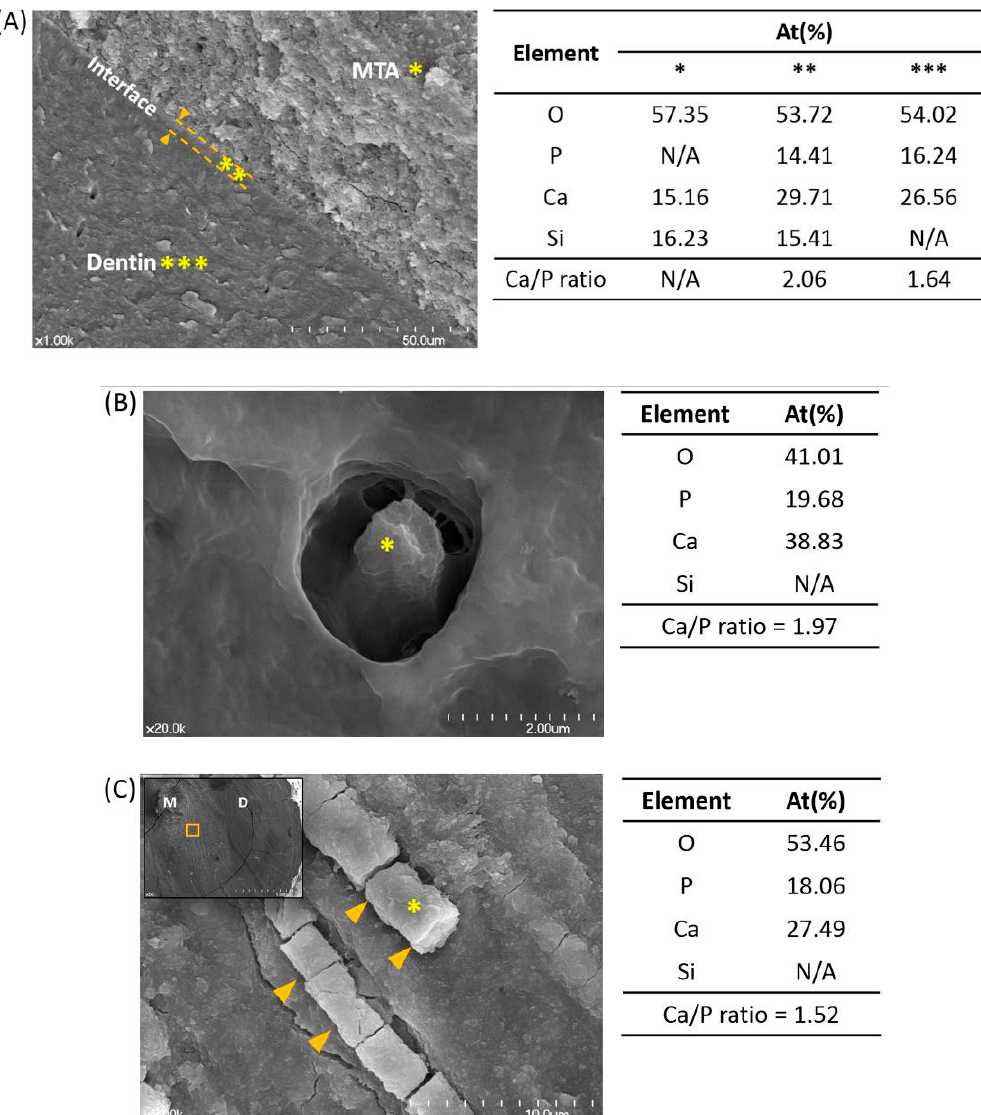
Figure 2. Scanning electron microscopic images that are representative of the root canal dentin and mineral trioxide aggregate (MTA) interface. ( A ) There was an intermediate layer (**) at the interface of MTA (*) and dentin (***) (×1000). ( B ) A dentinal tubule that was occluded by a mineralized structure (×20,000). ( C ) Higher magnification image (×50,000) of yellow boxed area in upper left image showing horizontal cross-sectional view of the root (×50). Biomineralized dentinal tubules (arrowheads) at 1.0–2.0 mm distance from root canal. M: mineral trioxide aggregate; D: dentin. Tables show semiquantitative chemical composition showing Ca/P ratio of the pointed areas (*) in each figure.